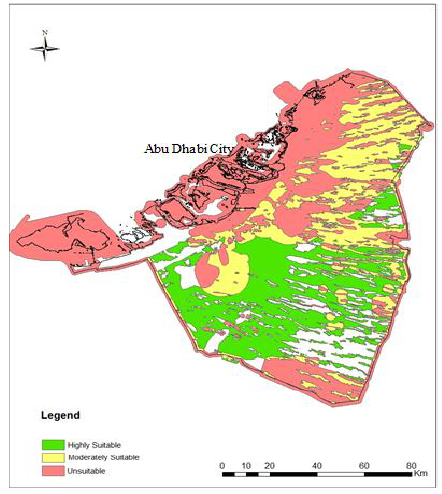
Figure 2. Landfill site suitability in the study